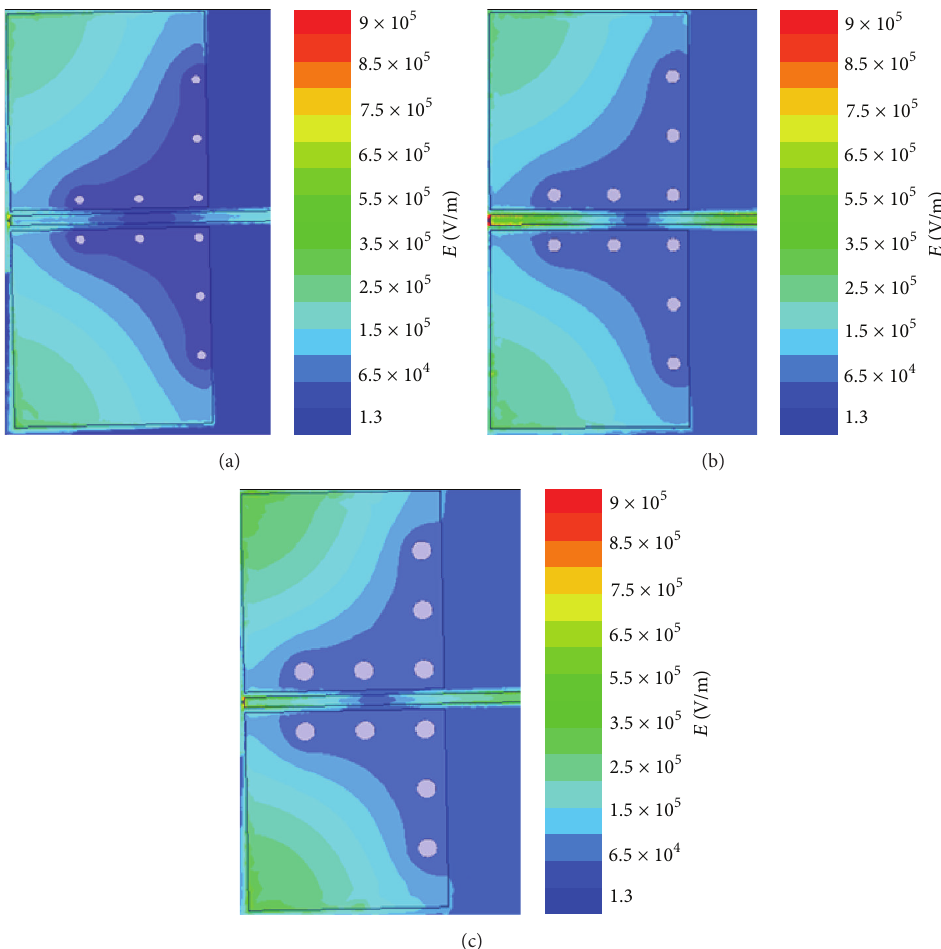
Figure 6: Electrical field distribution in a via-hole GCPW-MS transition at resonance peak; (a) via-hole diameter of 50 𝜇 m at 57 GHz, (b) via-hole diameter of 75 𝜇 m at 62GHz, and (c) via-hole diameter of 100 𝜇 m at 66